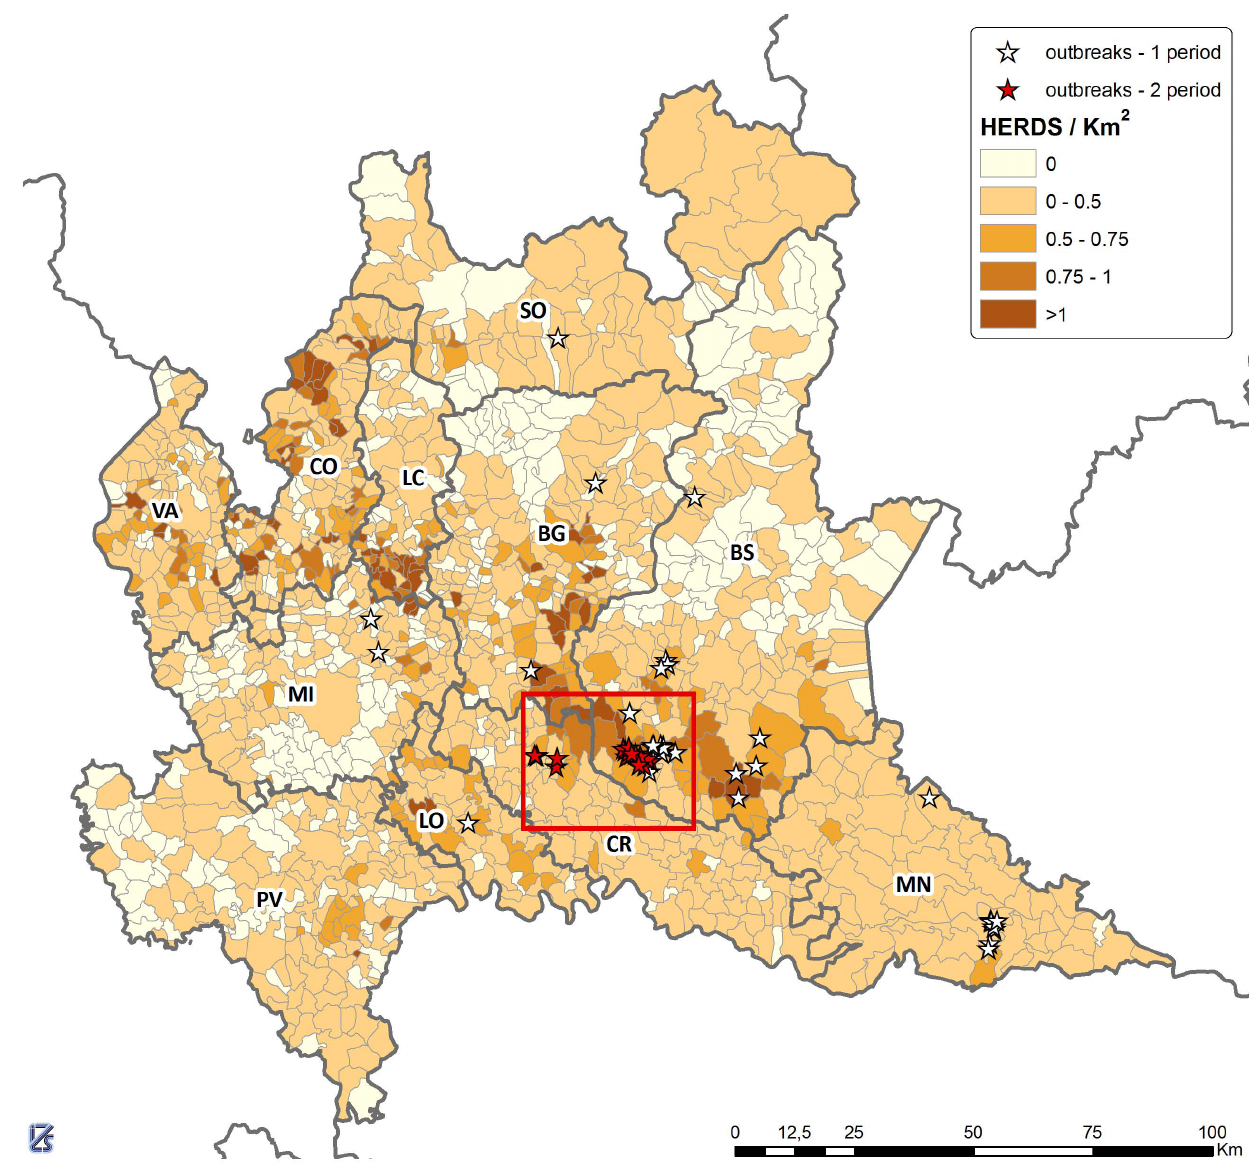
Figure 2. Outbreak locations. Map of Lombardy with the locations of the outbreaks arisen in the two epidemic periods (purple symbols: period 1, red symbols: period 2) and with municipalities color coded according to pig farm density (measured in herds per km 2 ). The labels are referring to the provinces; BG: Bergamo, BS: Brescia, CO: Como, CR: Cremona, LC: Lecco, LO: Lodi, MN: Mantua, MI: Milan, PV: Pavia, SO: Sondrio, VA: Varese. We note that the average farm density across a whole municipality is generally lower than the actual local farm density around farm locations in that municipality.